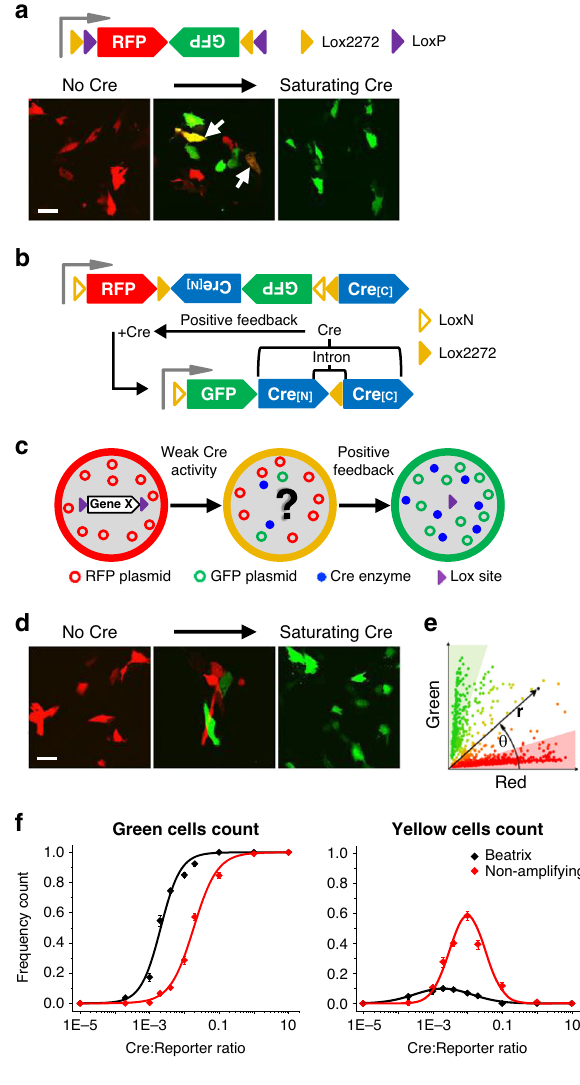
expressing only GFP in different mosaics. The embedded ampli fi cation strongly enhances the sensitivity of Beatrix to low trigger plasmid titers, shifting the 50% point of the dose-effect sigmoidal fi t toward a tenfold lower concentration (from a Cre: affecting the slope. At the same time, the frequency of recombinant cells with uncertain status (yellow cells) is greatly reduced.